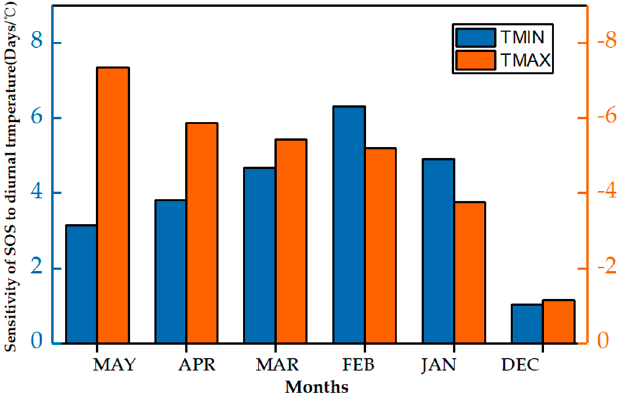
Figure 9. Sensitivity of the SOS to diurnal temperature across the boreal forest.